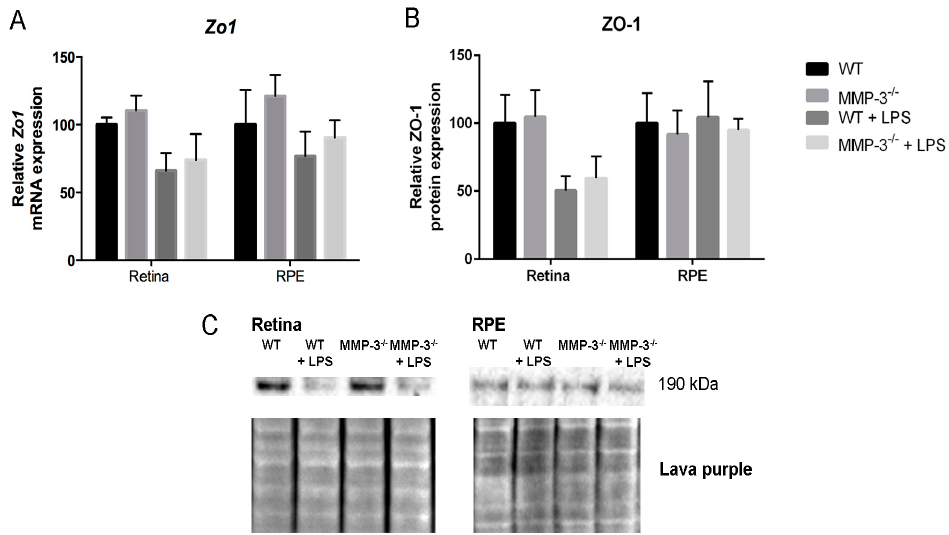
Figure 7. The impact of MMP-3 deficiency on ZO-1 in the retina and RPE during EIU. ( A ) Real time-PCR data showed a clear reduction, although not significant, in Zo1 mRNA levels in the retina of WT and MMP-3 − / − mice after EIU induction, which was not observed in the RPE; ( B , C ) Additional Western blot analysis of ZO-1 in the retina and RPE confirmed these data. Lava purple staining served as a loading control. Western blot data were normalized against Lava purple total protein stain and expressed as a percentage relative to 0 hpi. ( A – C ) MMP-3 deficiency did not affect ZO-1 levels during EIU at the posterior eye segment. Data are shown as mean ± SEM, n ≥ 5.